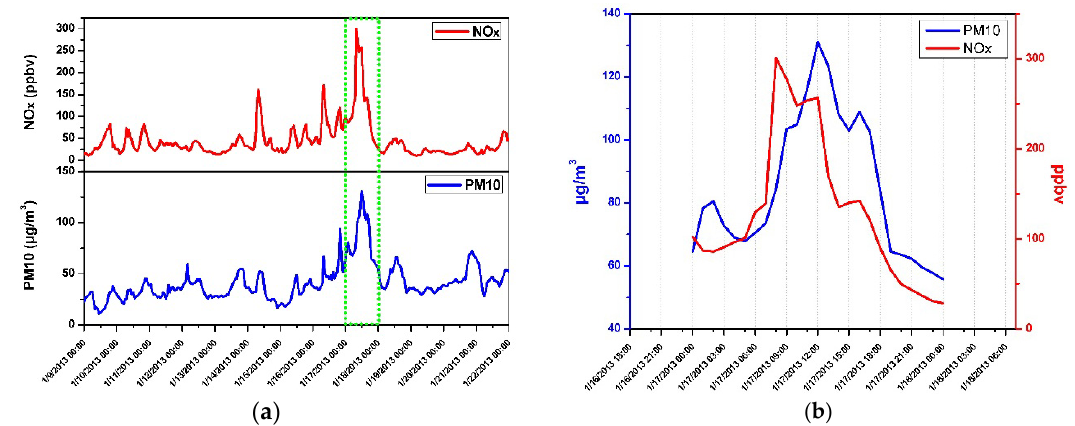
Figure 11. ( a ): Lille air quality monitoring data of NOx and PM10 (“Source Atmo Nord–Pas